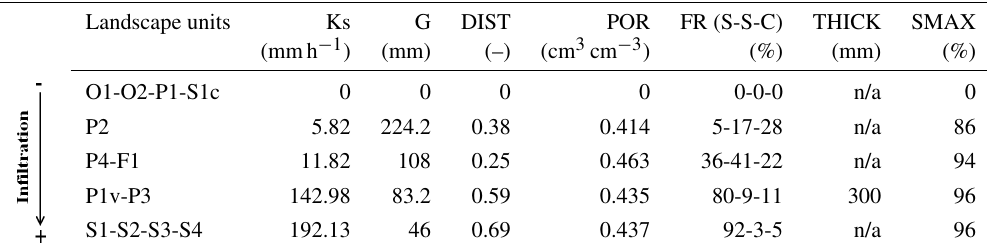
Table 3: Summary of hydrological parameters for each landscape unit, sorted by increasing infiltration (Ks: saturated hydraulic conductivity, POR: soil porosity, G: capillary charge saturation, DIST: pore distribution, FR: fraction of sand, silt and clay, and THICK: upper soil